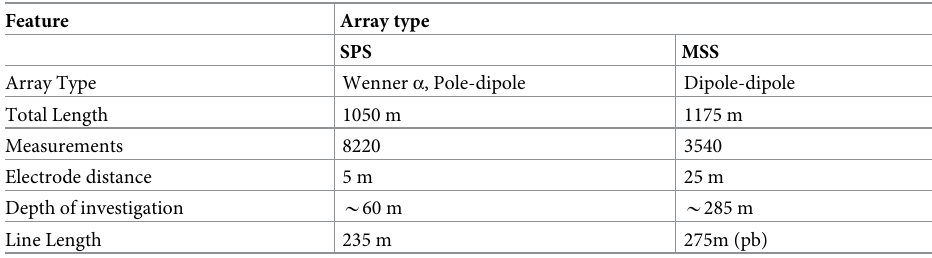
Table 1. Summary of SP and MS main acquisition